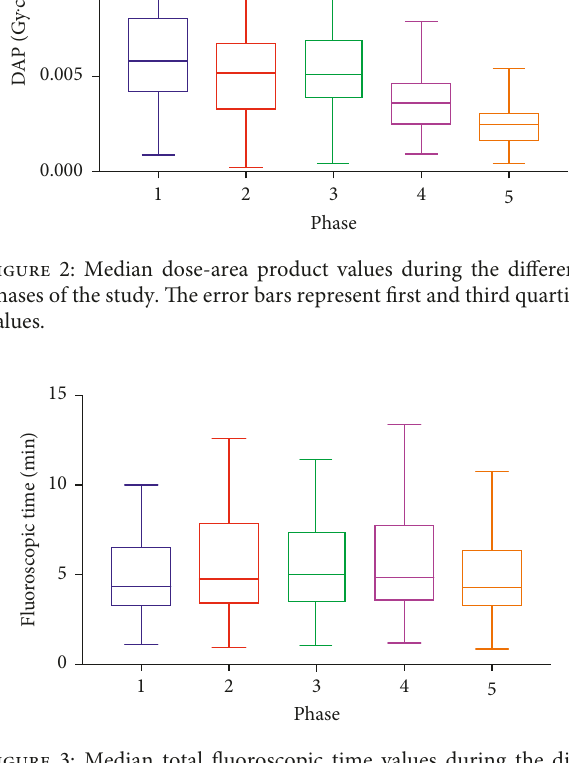
Figure 3: Median total fluoroscopic time values during the dif- ferent phases of the study. The error bars represent first and third quartile